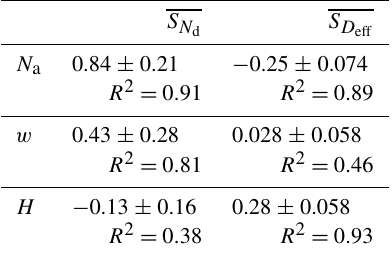
Table 3. N d and D eff averaged sensitivities to N a , w , and H . Stan- dard deviations are also shown. R 2 values are averages of the in- dividual fits. The total variations for N a , w , and H are 500 to 4500cm − 3 , 0 to 8ms − 1 , and 0 to 4156m, respectively. Intervals grow logarithmically (or close to) for w and H